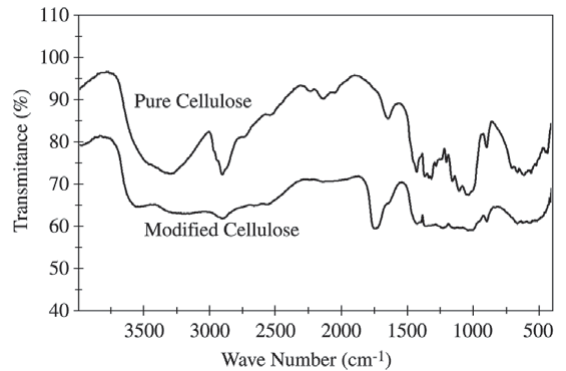
Figure 1. Infrared spectra of pure cellulose and cellulose modi- fied with p-aminobenzoic groups.